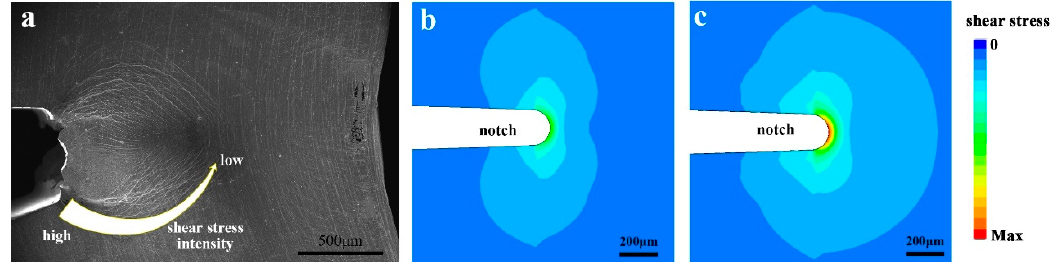
Figure 8. A comparison of shear band distribution and shear stress distribution near the notch tip of a Pd 77.5 Cu 6 Si 16.5 MG during 3-point bending. ( a ) The shear band distribution near the notch tip of the sample. ( b ) Simulated shear stress distribution on the side surface of the sample. ( c ) Simulated shear stress distribution in the middle of the